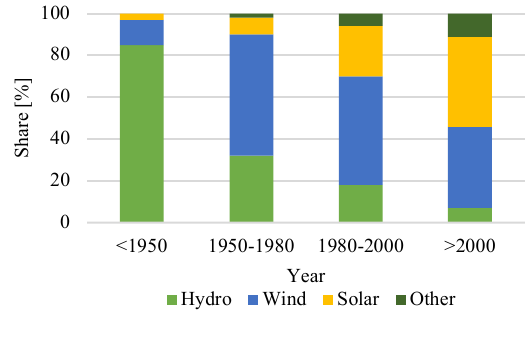
Fig. 1. RES development in CE.